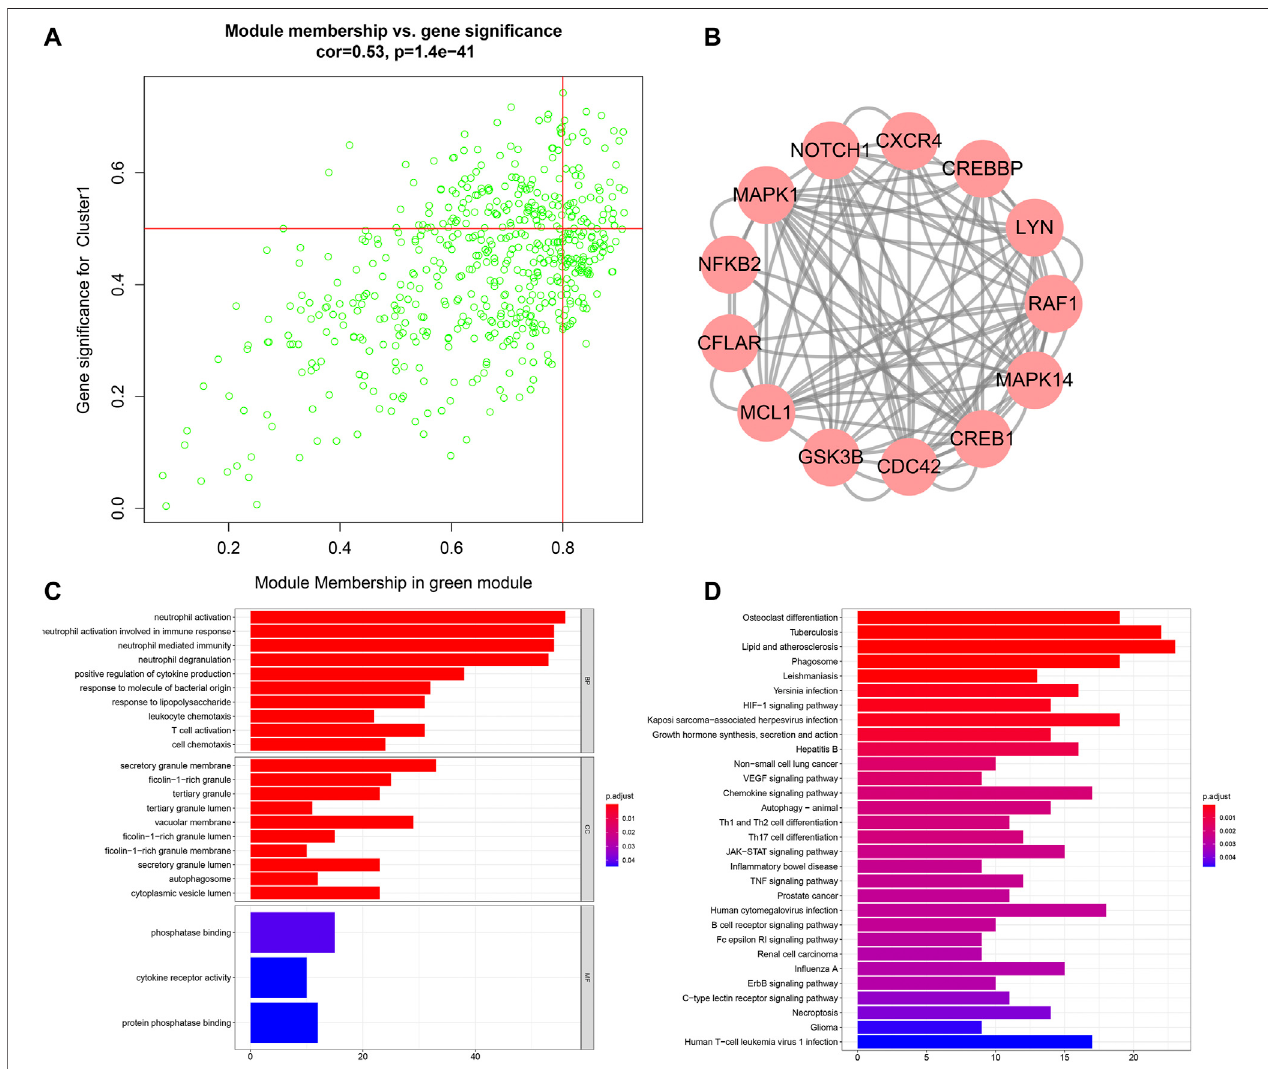
FIGURE7| Analysisofgenesintheaging-related co-expression module. (A) Scatterplotsfortheinteractionsbetweenmodulemembershipandgenesigni fi cance forgenesinthegreenmodule. (B) HubgenesamonggenesinthegreenmoduleviatheMCODEmethod. (C) Biologicalprocesses(BPs),cellularcomponents(CCs),and molecular functions (MFs) enriched by genes in the green module. (D) KEGG pathways enriched by genes in the green module.